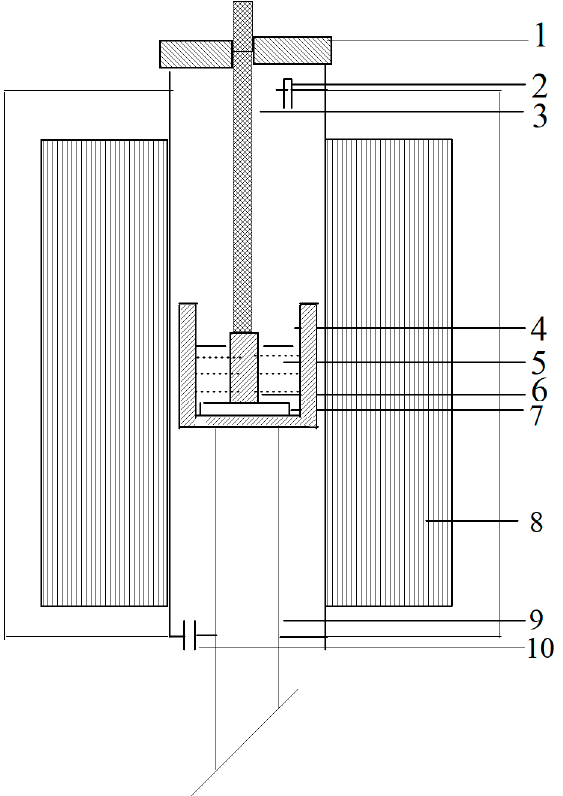
Figure 1. Schematic diagram of a modified Rapoport. (1) Stainless steel cover (2) Argon gate (3) C-Ni-Cr alloy cathode rod (4) High purity graphite crucible. (5) Electrolyte (6) Semigraphitic cathode (7) Boron nitride plate. (8) Furnace (9) Graphite mechanical support. (10) Argon inlet.